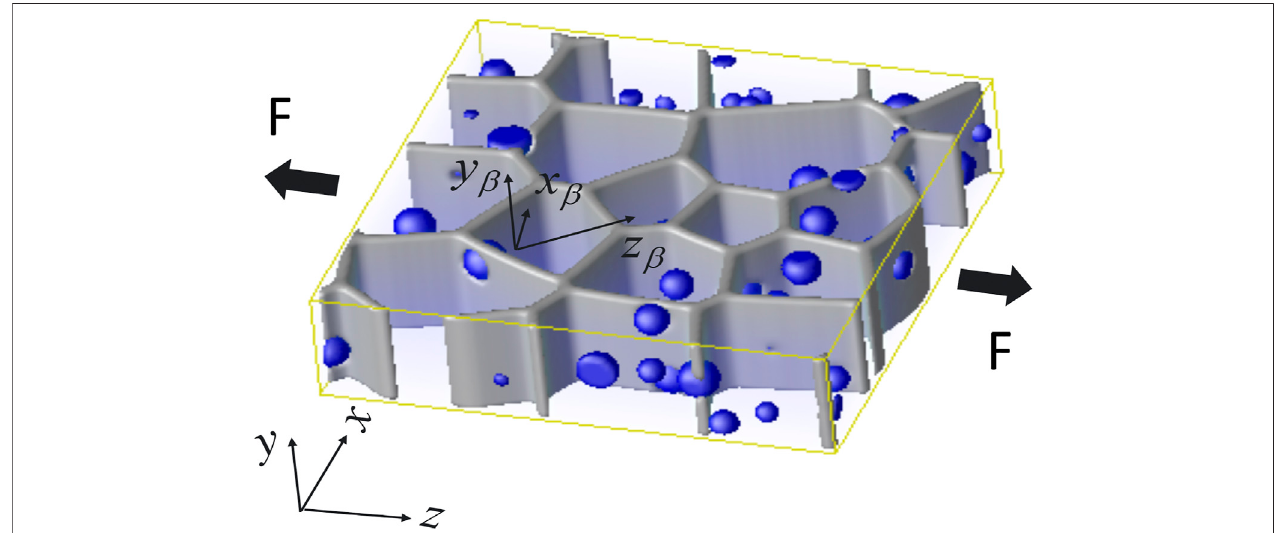
FIGURE 2 | Illustration of polycrystalline UMo with distributed gas bubbles, where F is the applied force.